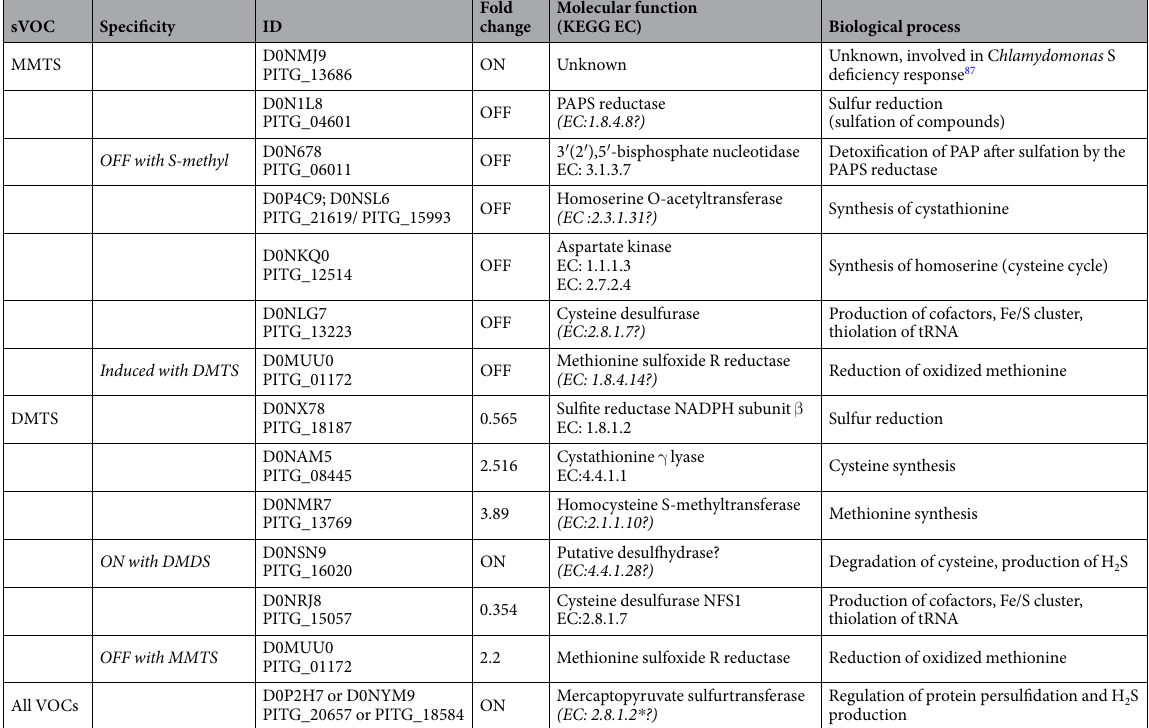
Table 2. Proteins regulated by sVOCs and involved in the sulfur metabolism. EC numbers in italics and brackets are propositions of enzymatic functions. * Works with EC 2.8.1.7 in the sulfur relay system (thiolation of tRNA/synthesis of molybdenum) with production of H 2 S.